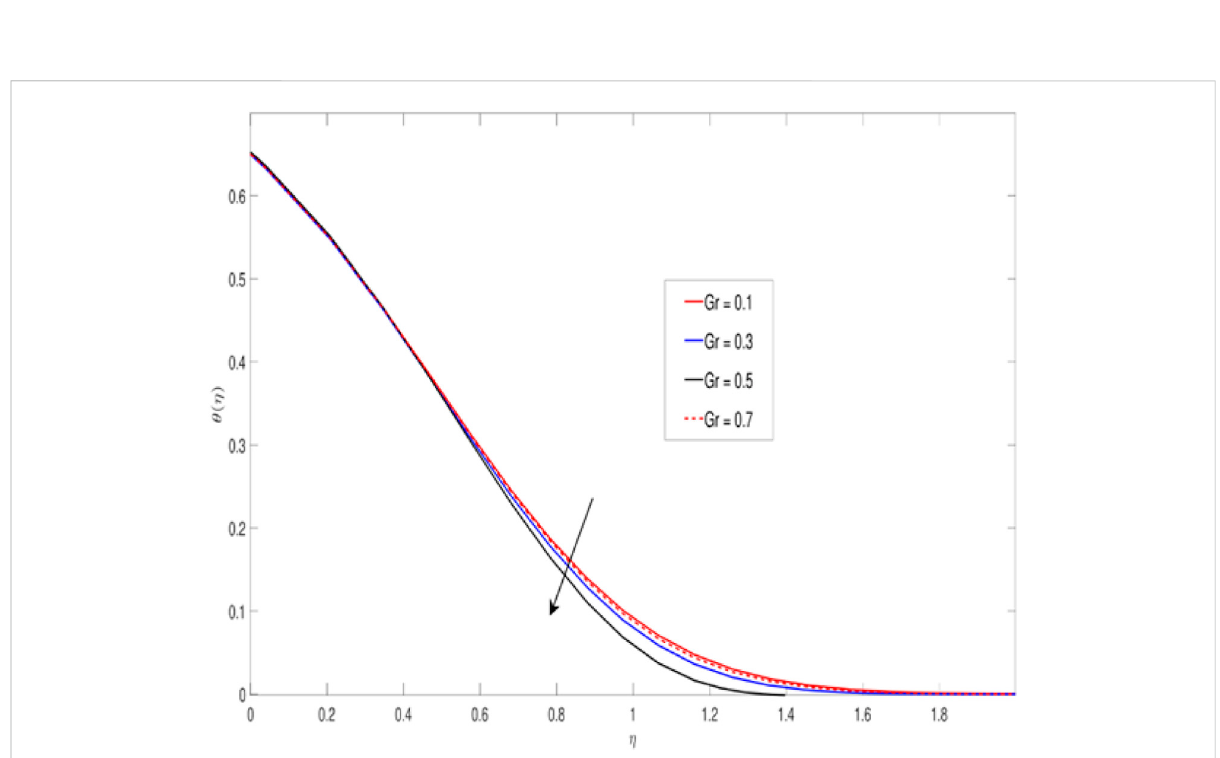
FIGURE 10 Temperature distribution vs. modi fi cation of the favored buoyancy